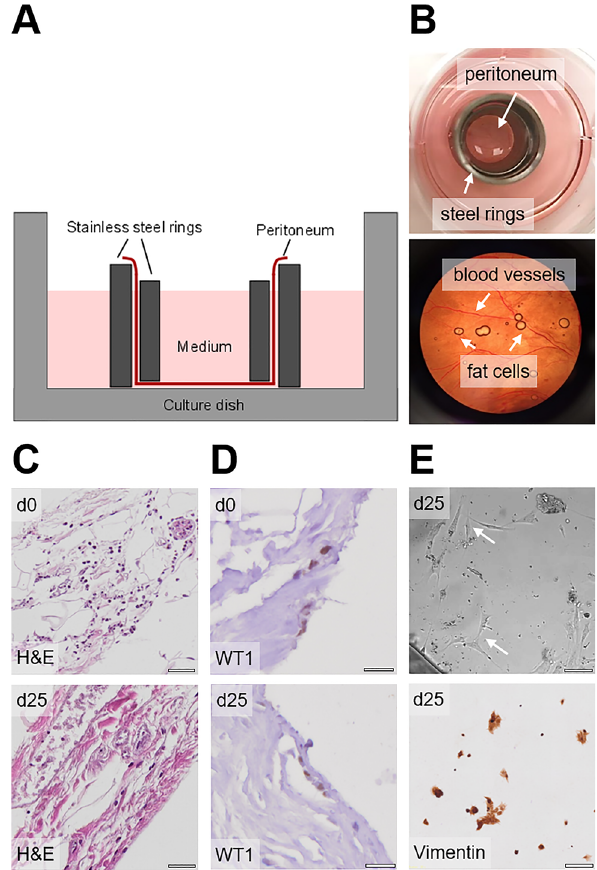
Figure 1: Establishment of a human ex vivo peritoneal model. (A) Schematic setup of the ex vivo peritoneal model. (B) Photographic images of the peritoneal model. (C) H&E staining of peritoneal tissue on day 0 and day 25 of culture; scale bars 200 µm. (D) WT1 staining of peritoneal mesothelial cells on day 0 and day 25; scale bars 20 µm. (E) Light microscopy and vimentin staining of outgrowing fi broblasts on day 25; scale bars 200 μ